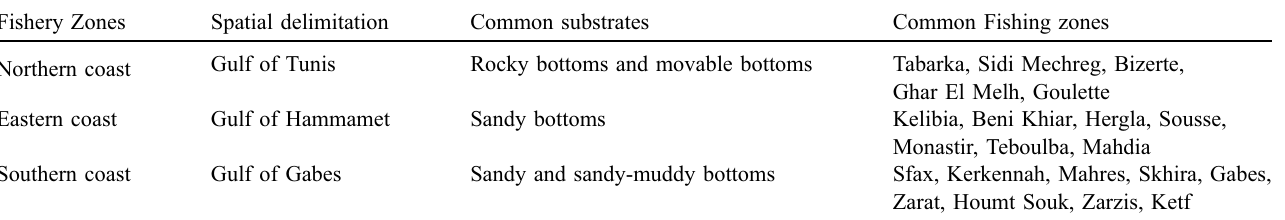
Table 1. Major characteristics of marine coastal area of Tunisia (Ktari-Chakroun and Azouz, 1971; Ben Othman, 1973; Oueslati, 1993).